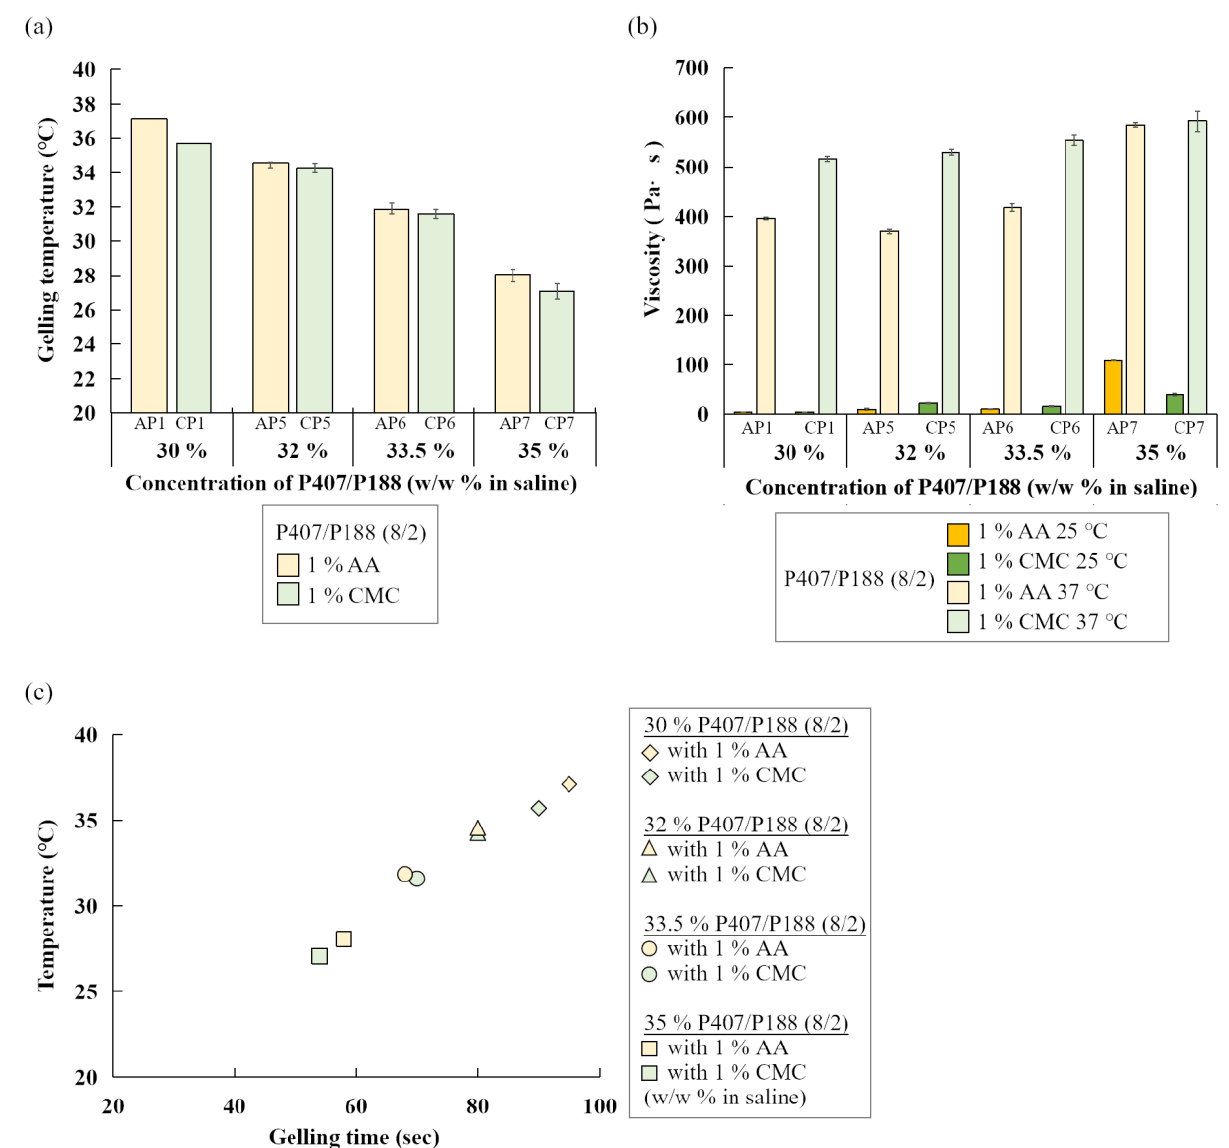
Figure 4. ( a ) Average gelling temperature, ( b ) average viscosity, and ( c ) gelation time of different concentrations of total poloxamers (30, 32, 33,5, 35% w / w of P407/P188 blended mixtures at 8/2 ratio) with 1% of AA (yellow bars, yellow marks) or CMC (green bars, green marks).